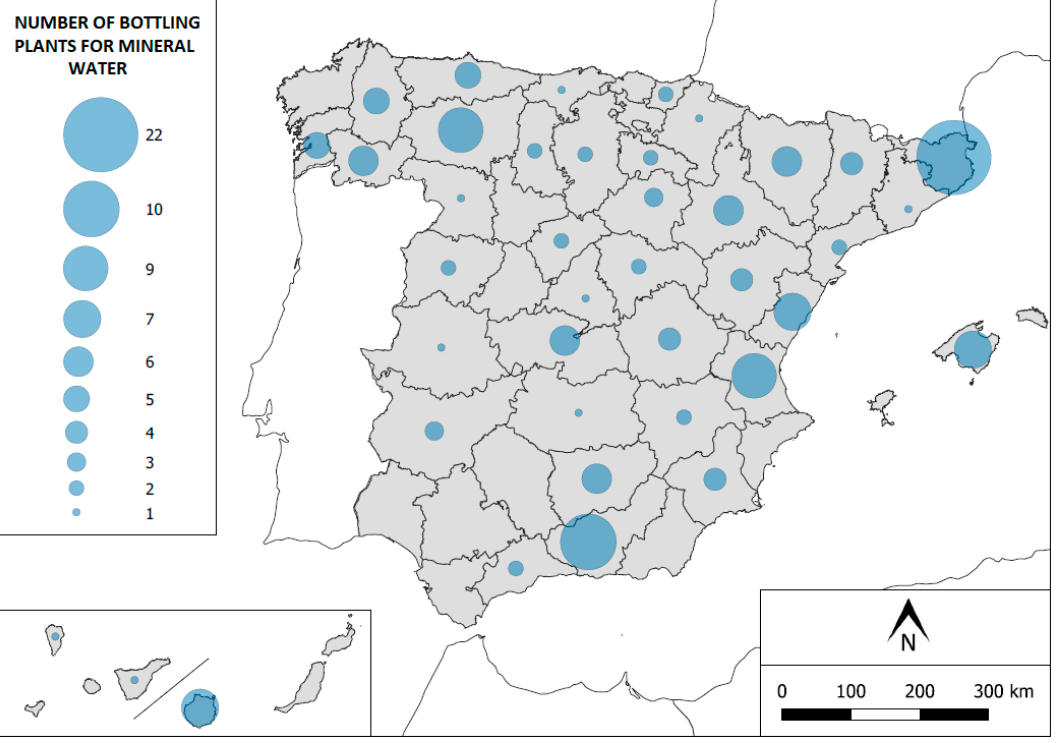
Figure 3. Distribution of bottling plants for mineral water in Spain for the year 2019. Source: authors’ elaboration from the European Commission data (List of Mineral Waters Recognized by the Member States) (consultation on 8 February 2019).